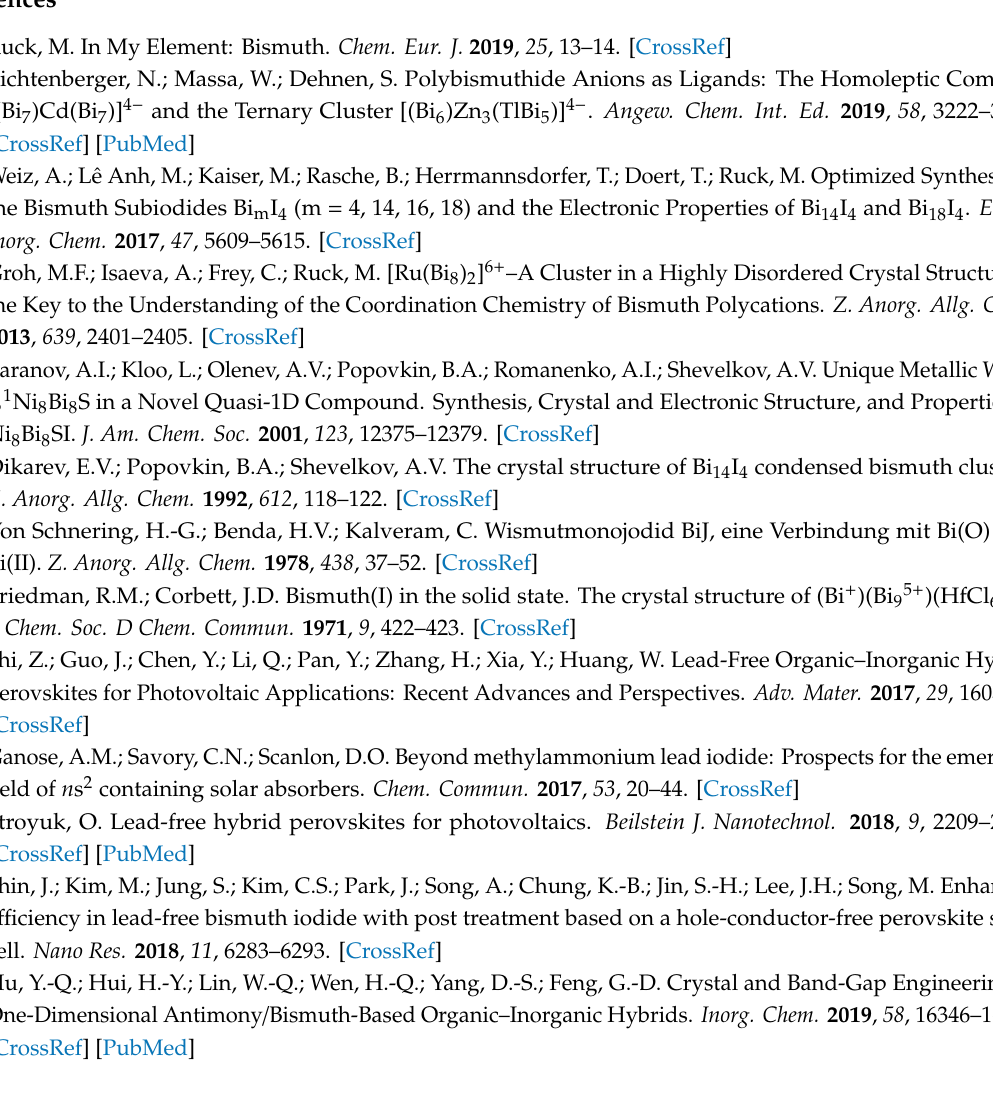
Supplementary Materials: The following are available online, Figure S1: X-ray powder di ff raction pattern for (HpipeH 2 ) 2 Bi 2 I 10 · 2H 2 O, Figure S2: Thermal analysis data for (HpipeH 2 ) 2 Bi 2 I 10 · 2H 2 O, Figure S3: Thermal analysis data for